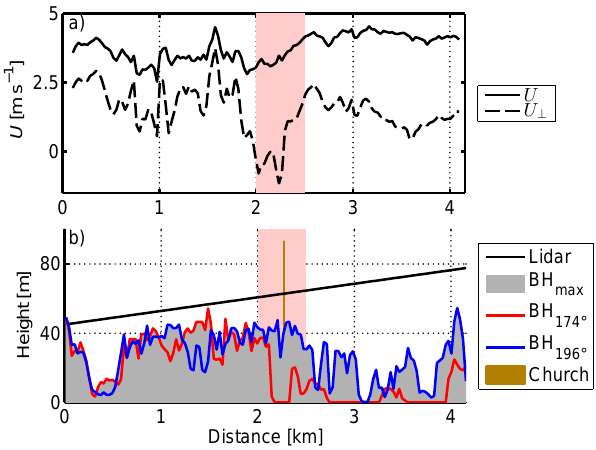
Figure 4. (a) Average horizontal wind speed and crosswind speed estimated by the Doppler lidar. (b) The height (ma.s.l.) of the li- dar beam and building height (BH) ± 25m laterally underneath the paths (total, and under beam with azimuth 174 and 196 ◦ ). When there are no buildings below the path, BH indicates the height of highest ground point or zero when it is over sea.